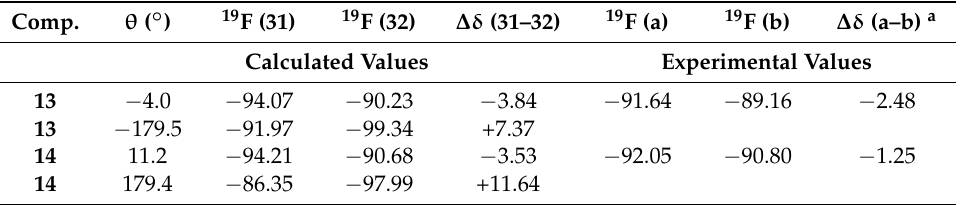
Table 2. Calculated (CHCl 3 ) and experimental 19 F-NMR chemical shifts (CDCl 3 ). Comp.